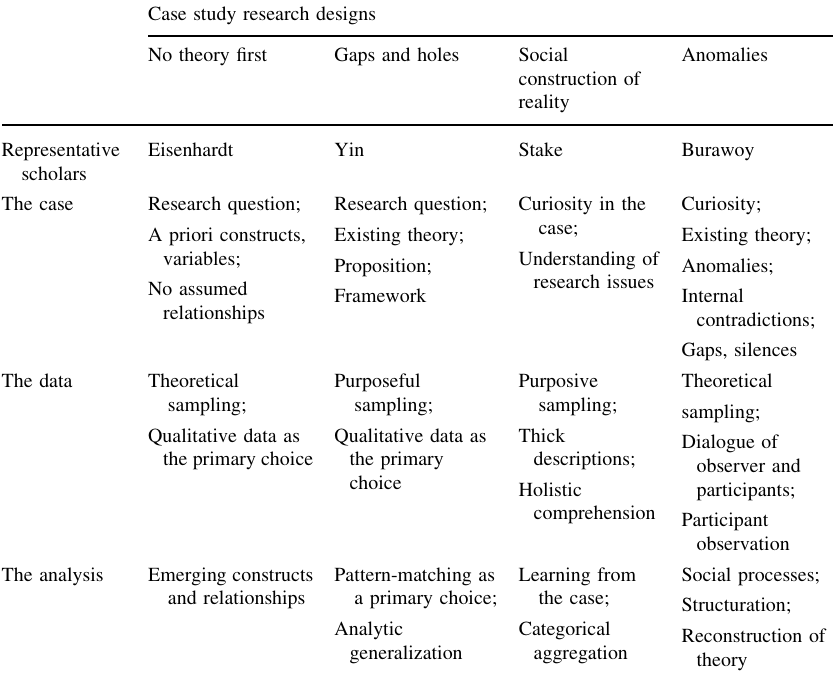
Table 1 Portfolio of case study research design: differences in underlying elements Case study research